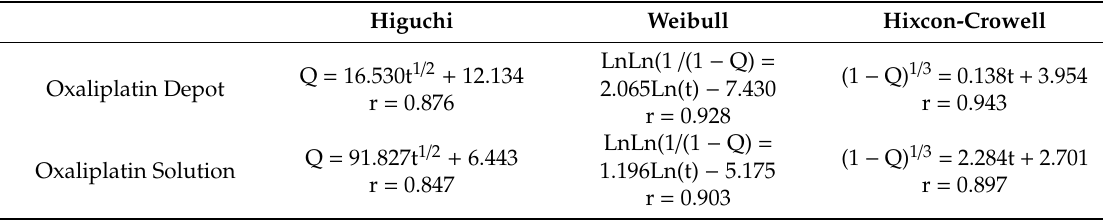
Table 2. Fitting equations and correlation coe ffi cients for the in vitro oxaliplatin release in rat plasmas.